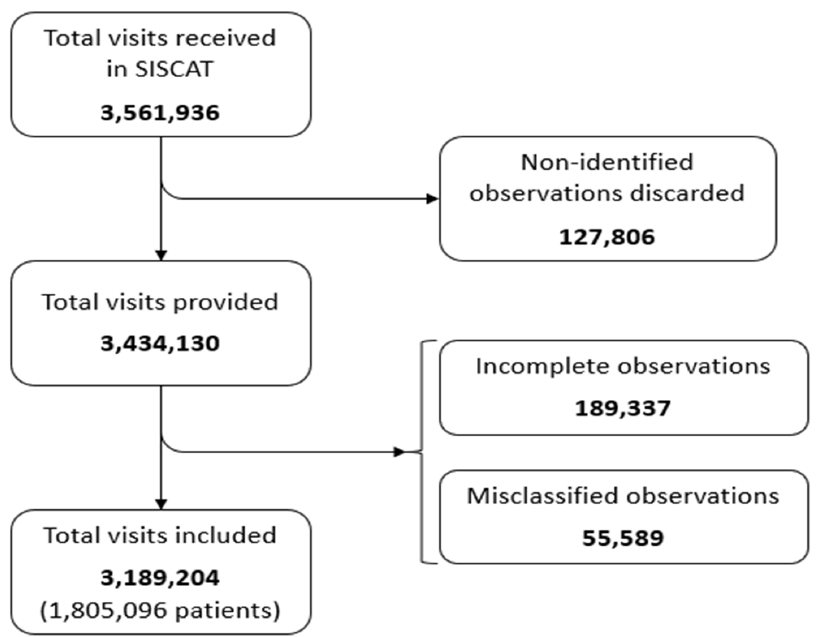
Figure 2. Patients included in the analysis.